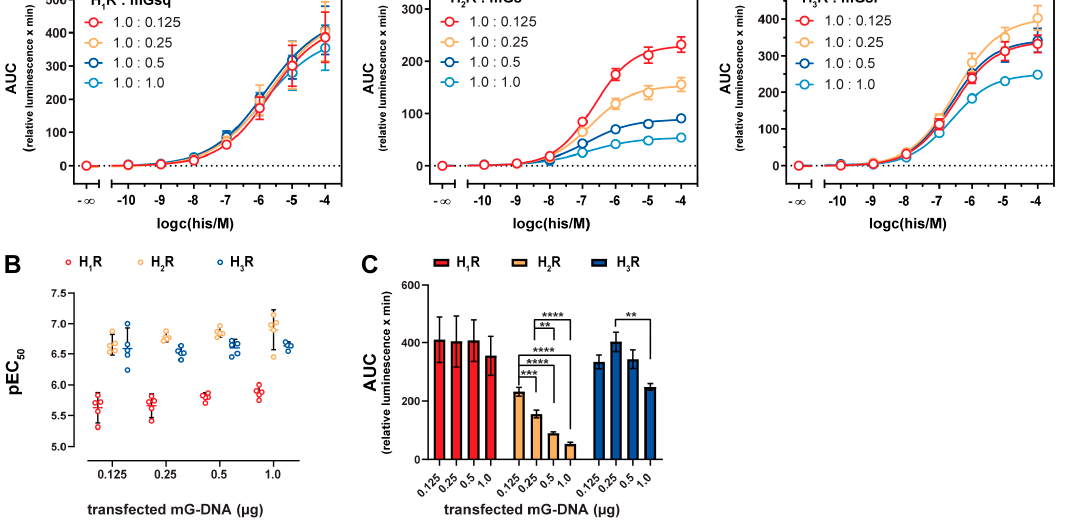
Figure 3. Concentration response curves and functional parameters obtained in the mini-G protein recruitment assay with di ff erent mini-G protein expression levels. ( A ) Concentration response curves, ( B ) pEC 50 values and ( C ) AUCs of histamine obtained in the mini-G recruitment assay using HEK293T cells transiently transfected with indicated DNA amounts (in µ g) of the H 1–3 R-NlucC and NlucN-mGsq / mGs / mGsi constructs 72 h prior to the experiments. Presented data are from five independent experiments ( n = 5), each performed in triplicate. Whiskers ( B ) represent 95% confidential intervals. Significance levels ( C ) were calculated using one-way ANOVA followed by Tukey’s multiple comparison test calculated as ** p < 0.01, *** p < 0.005, **** p < 0.0001.